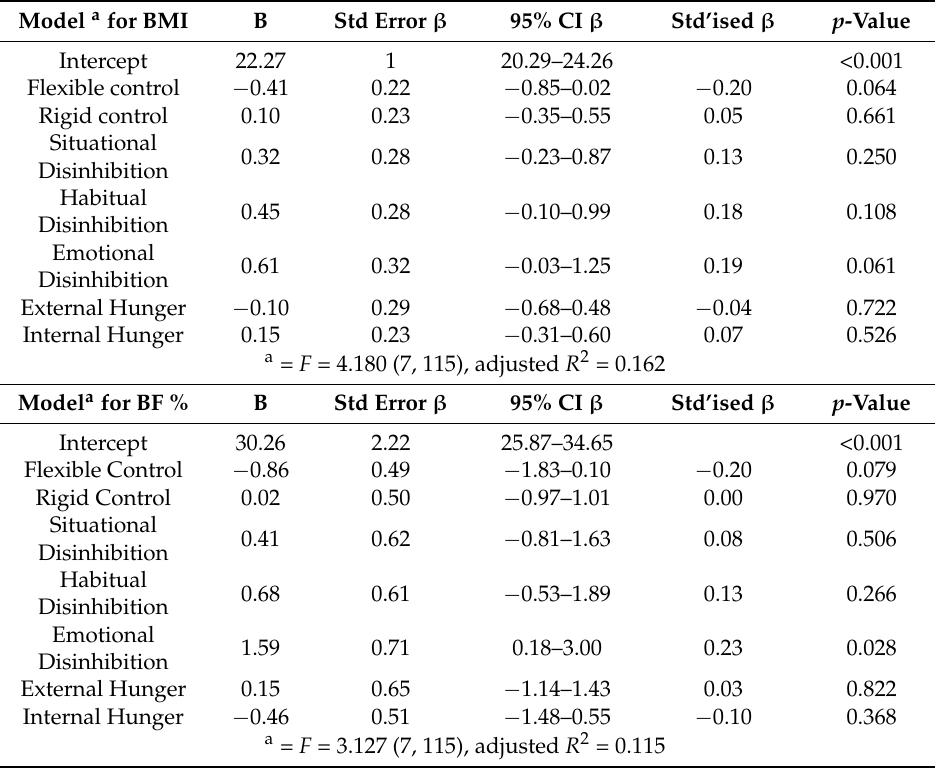
Table 3. Multiple Linear Regression of TFEQ sub-category factors’ correlation to BMI and BF